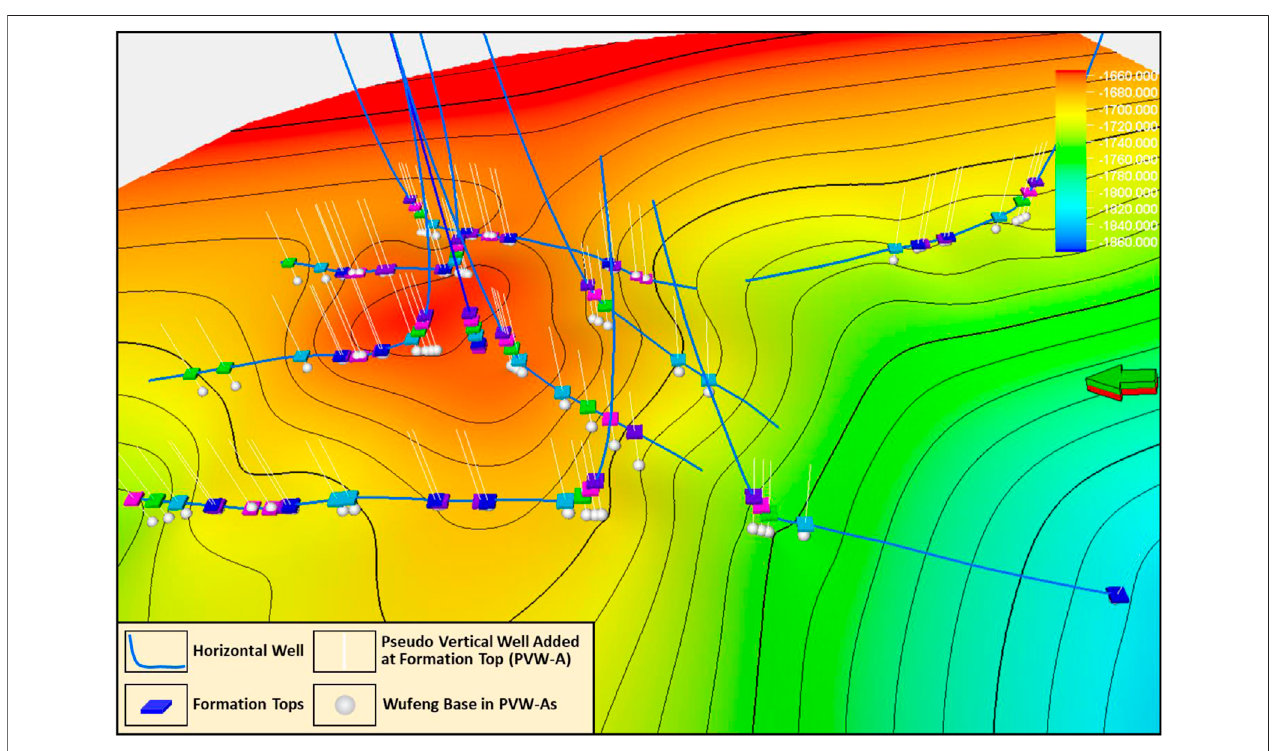
FIGURE 6 | Log-interpreted formation tops and the pseudo vertical wells added at these formation tops (PVW-As) with the inferred formation top of the Wufeng base. The structural map is the Wufeng base generated using the formation top in all wells, including the horizontal wells, the vertical wells, and PVW-As.